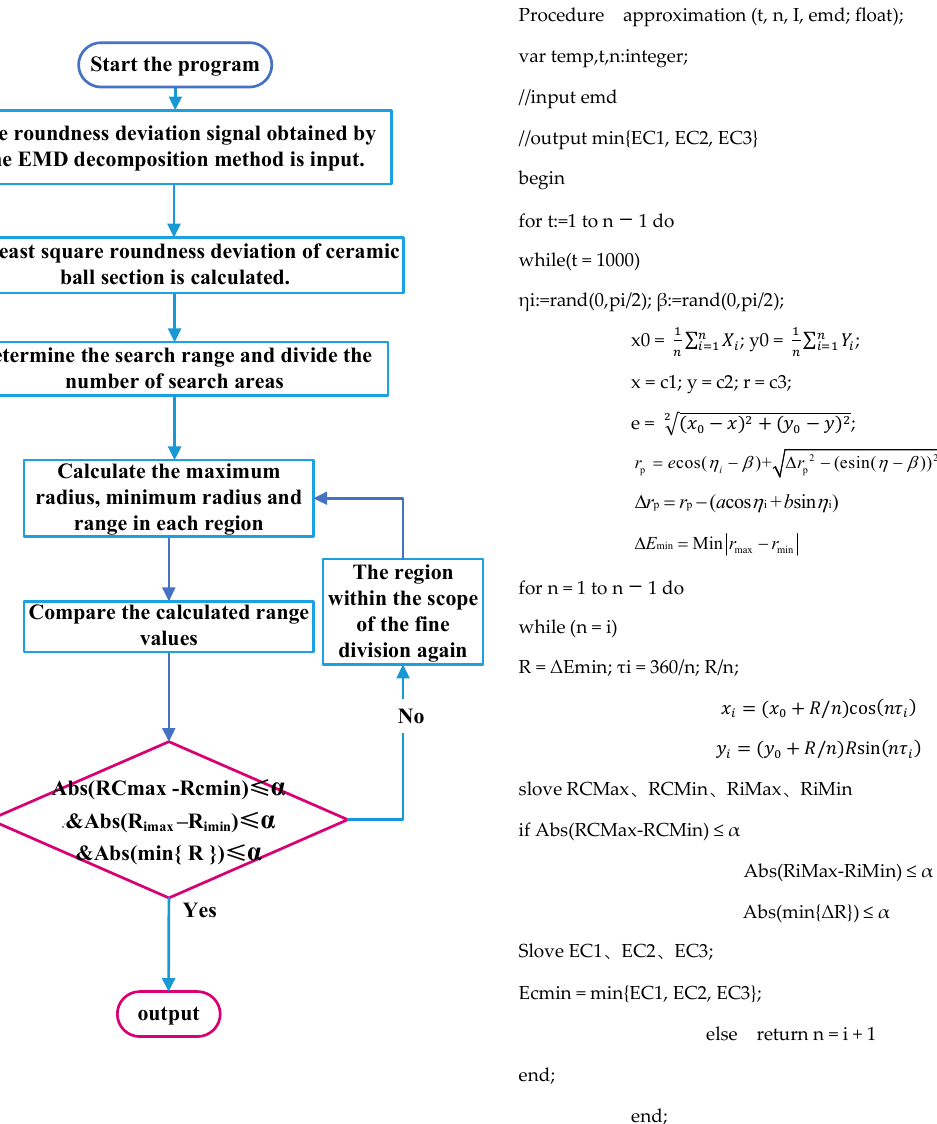
Figure 8. Algorithm flow chart and related pseudo-codes.